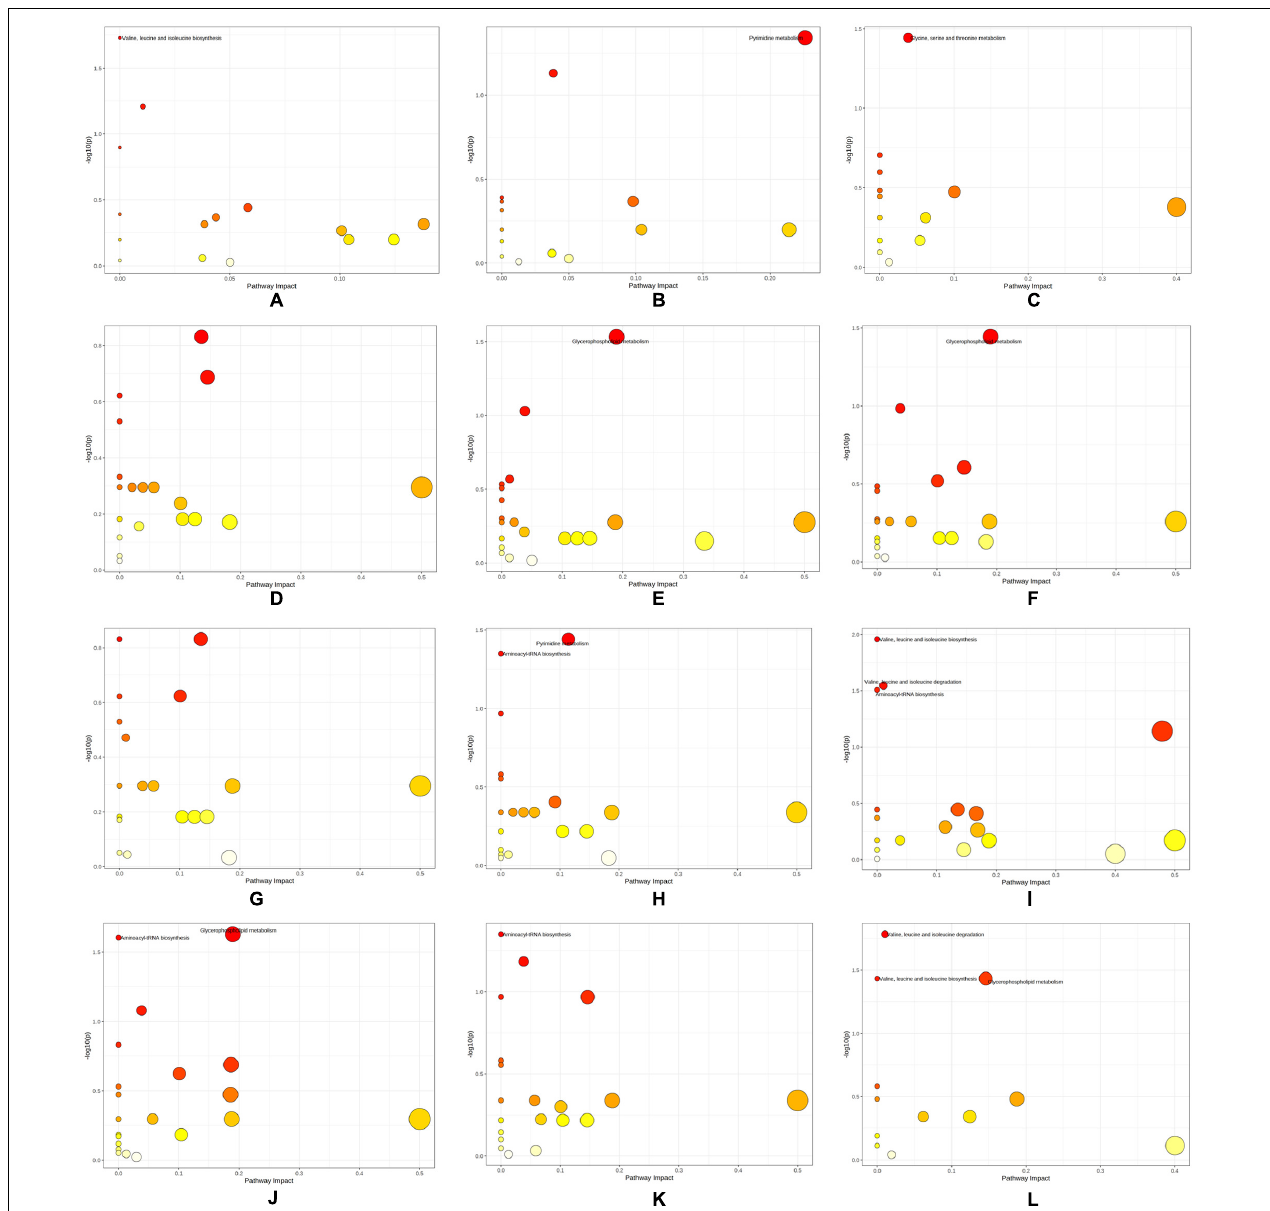
FIGURE 7 | Differential metabolic pathways obtained by KEGG enrichment analysis of differential metabolites. (A) SI_1 (B) SI_2 (C) SI_3 (D) SI_4 (E) SI_5 (F) SI_6 (G) SI_7 (H) SI_8 (I) SI_9 (J) SI_10 (K) SI_11 (L)